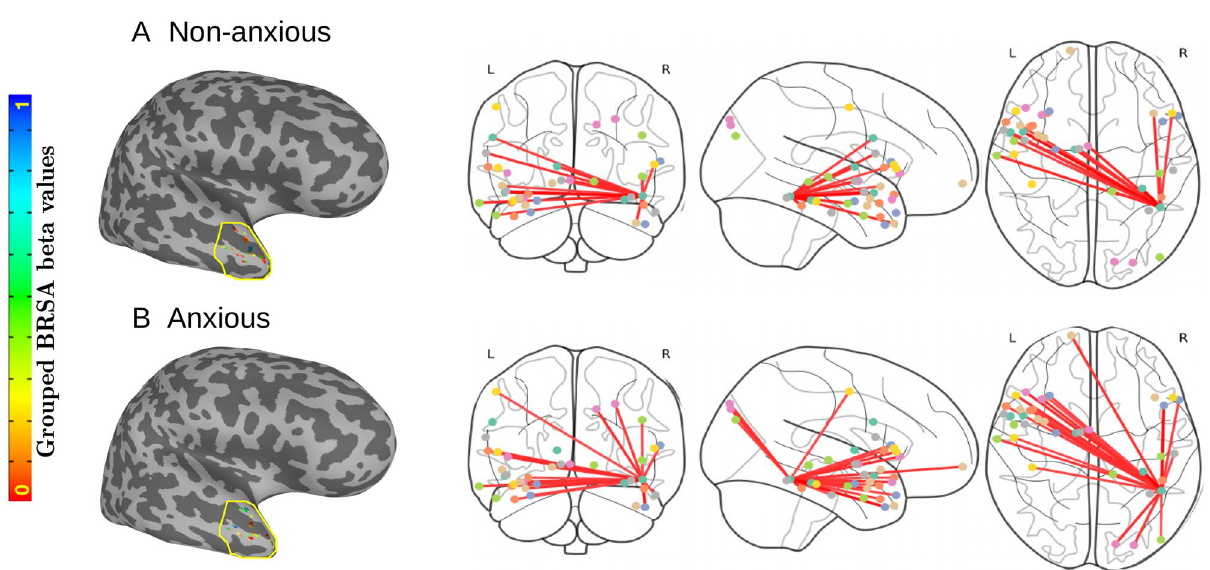
Figure 5. (Left) Grouped Bayesian representational similarity analysis of region #41. A between-group ROI analysis was used to examine activation differences for anxious versus non-anxious children. In our statistical comparisons, 685 pairs of mean beta values in region #41 were compared between each group using a Mann- Whitney U-test (two-tailed). (U = 215017.00, p < 0.005 ). (Right) Fully connected network analysis of Talairach region #41 with anxious versus non-anxious children. A visual representation of regions connected with region #41 . Dots represent the 38 regions with absolute correlation thresholds greater than 0.6, each connected with a red line to region #41 . ( A ) Fully connected network for non-anxious children. ( B ) Fully connected network for anxious